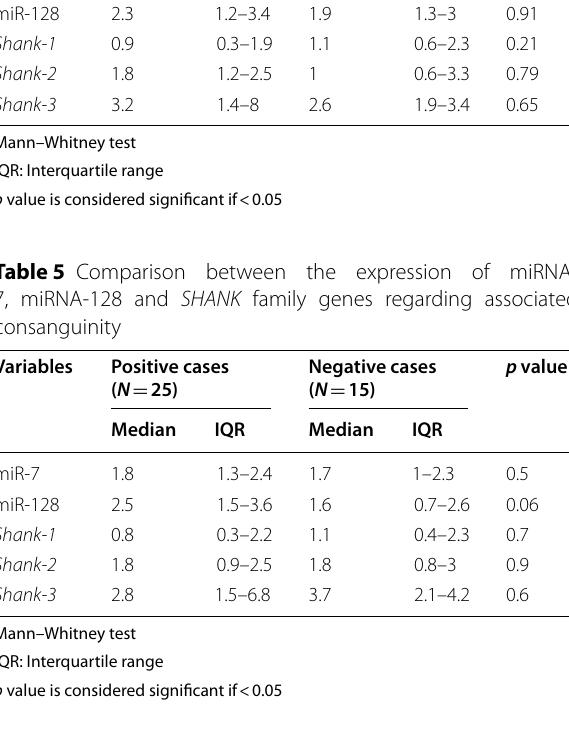
Table 7 Correlation analysis between the expression of miRNA‑7, miRNA‑128 and SHANK family genes